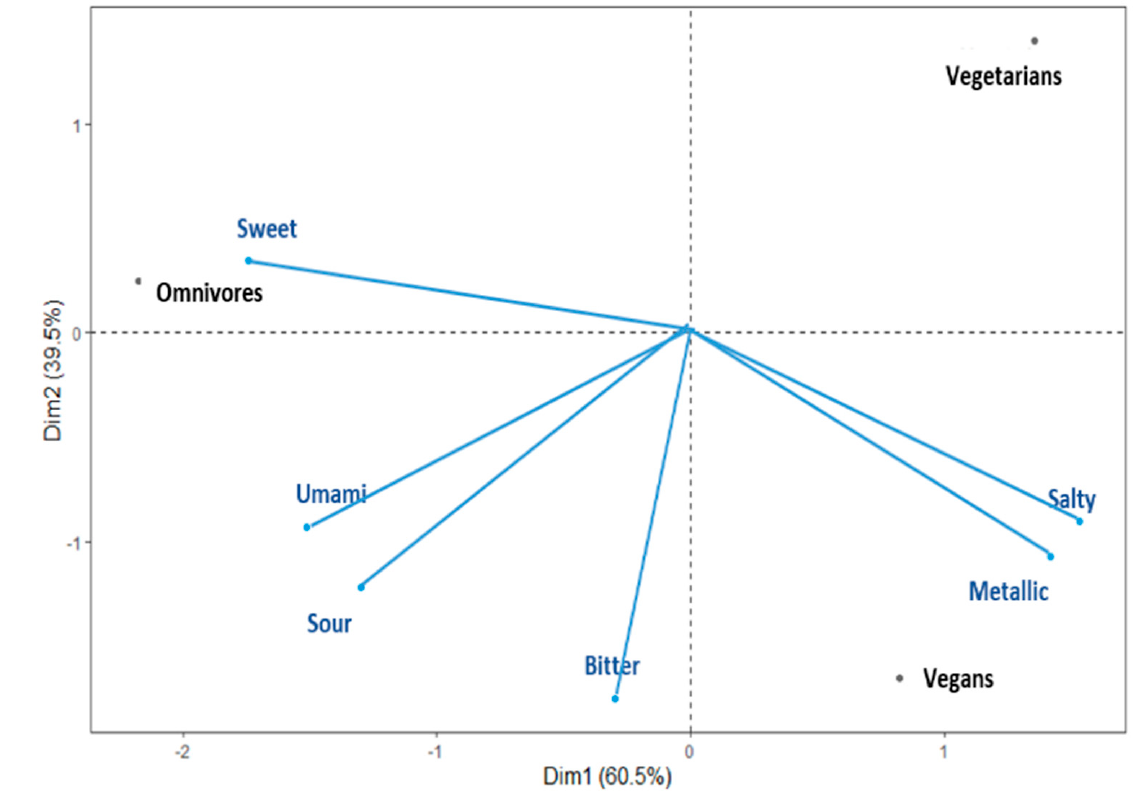
Figure 1. Principal component bi-plot graph for the vegan, vegetarian, and omnivore groups.